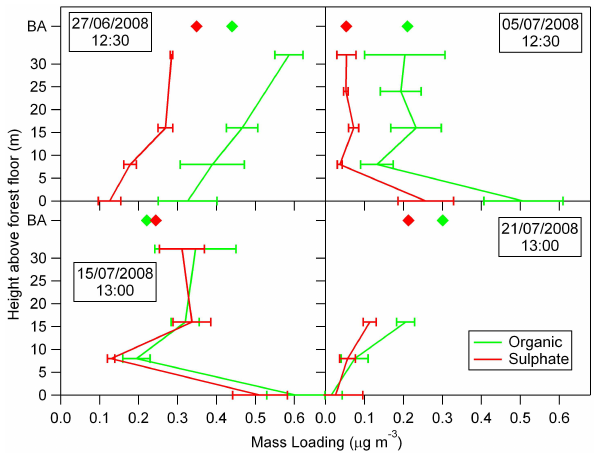
Fig. 11. Speciated aerosol concentration profiles within the canopy and trunk space from bag samples, analysed with the AMS. Values measured concurrently by the AMS above canopy at Bukit Atur are marked as diamonds and labelled “BA” on the left axis. Times are approximate local times at the start of sampling.